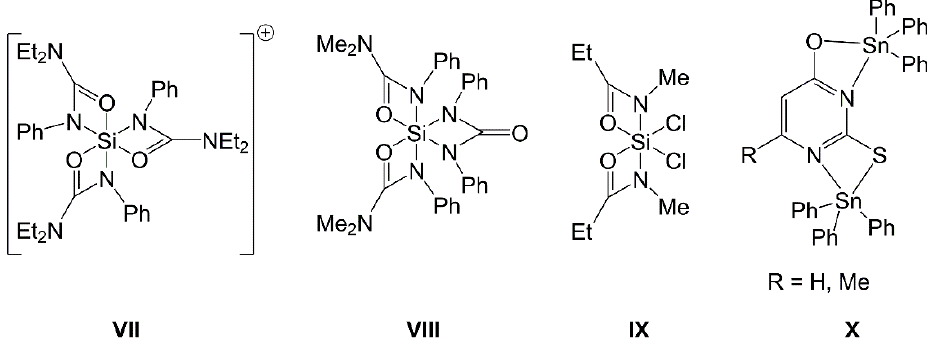
Figure 4 . Literature known examples of structurally confirmed hypercoordinate tetravalent tetrel ( E ) compounds (compounds VII − X ) with ( E ,O,C,N)-four-membered rings formed by mono-anionic (O,N)-chelating ligands.